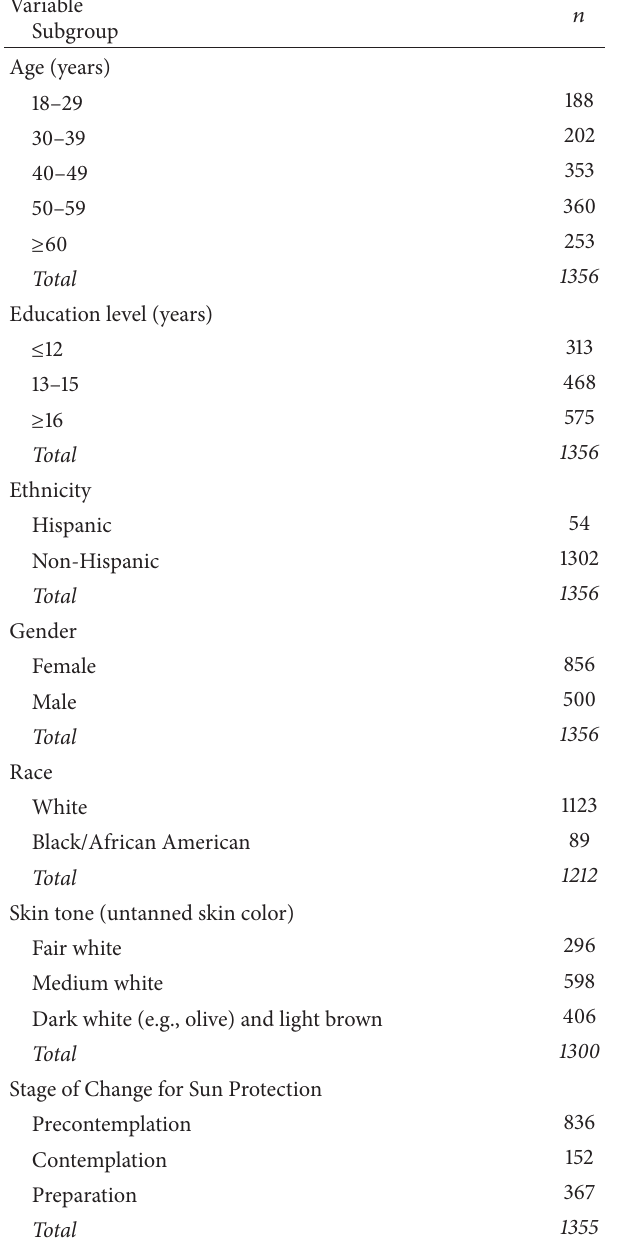
Table 1: Sample sizes for subgroups included in invariance